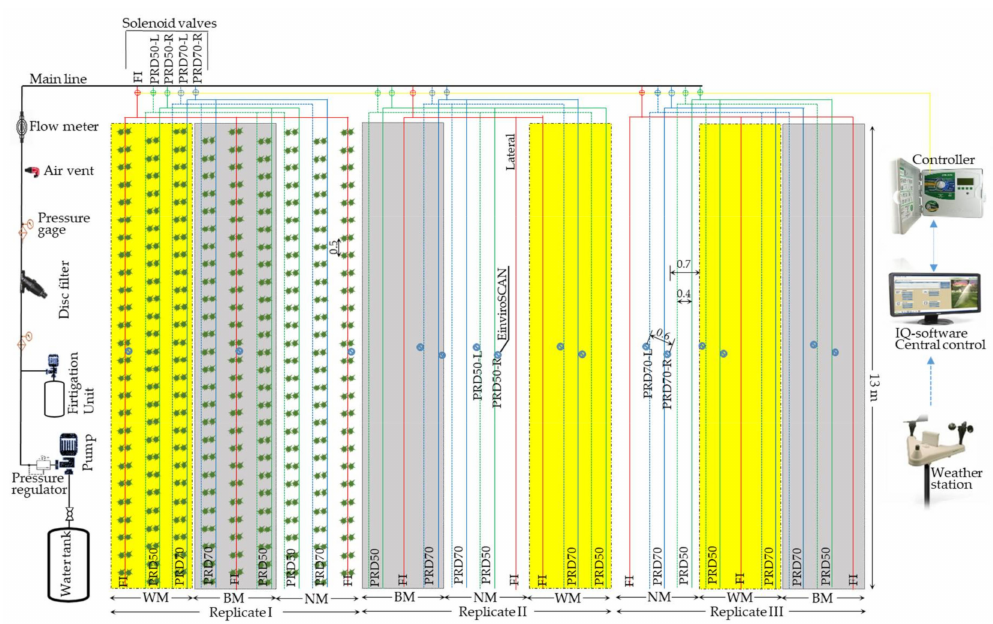
Figure 3. Schematic diagram of the experimental fields under mulch treatments (black mulch-BM, transparent mulch-WM and non-mulch- NM) and irrigation treatments (full irrigation-FI, partial root drying with 50% of evapotranspiration- PRD50, partial root drying with 70% of